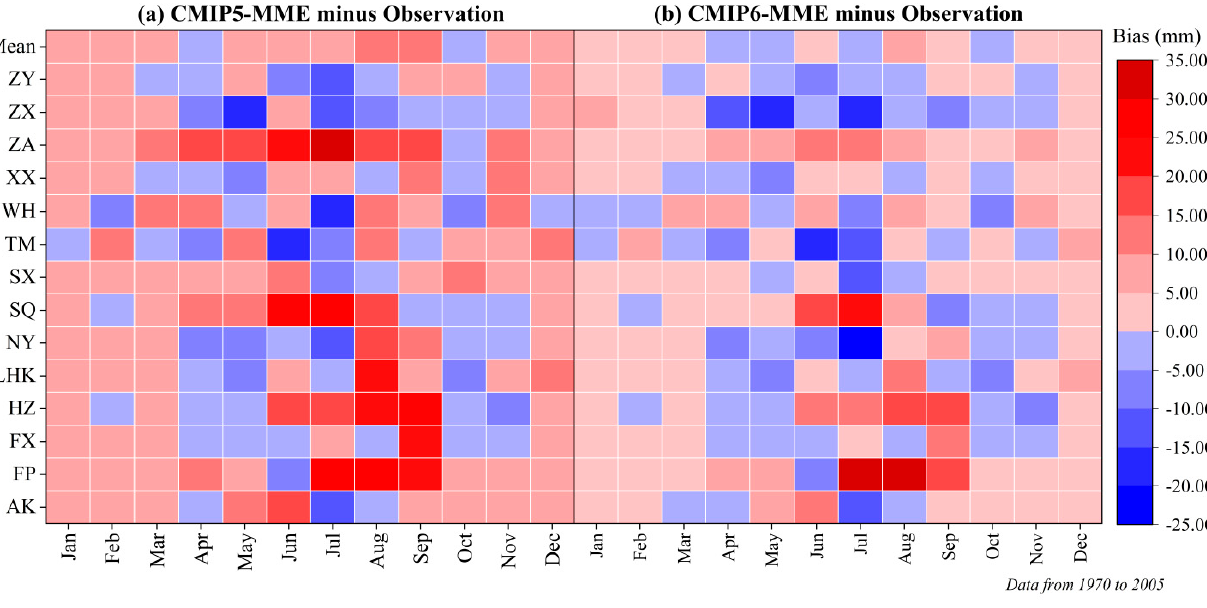
Figure 9. Monthly precipitation biases (GCM minus observation) ( a ) between CMIP5-MME downscaled data and observed data, and ( b ) between CMIP6-MME downscaled data and observed data for each station.